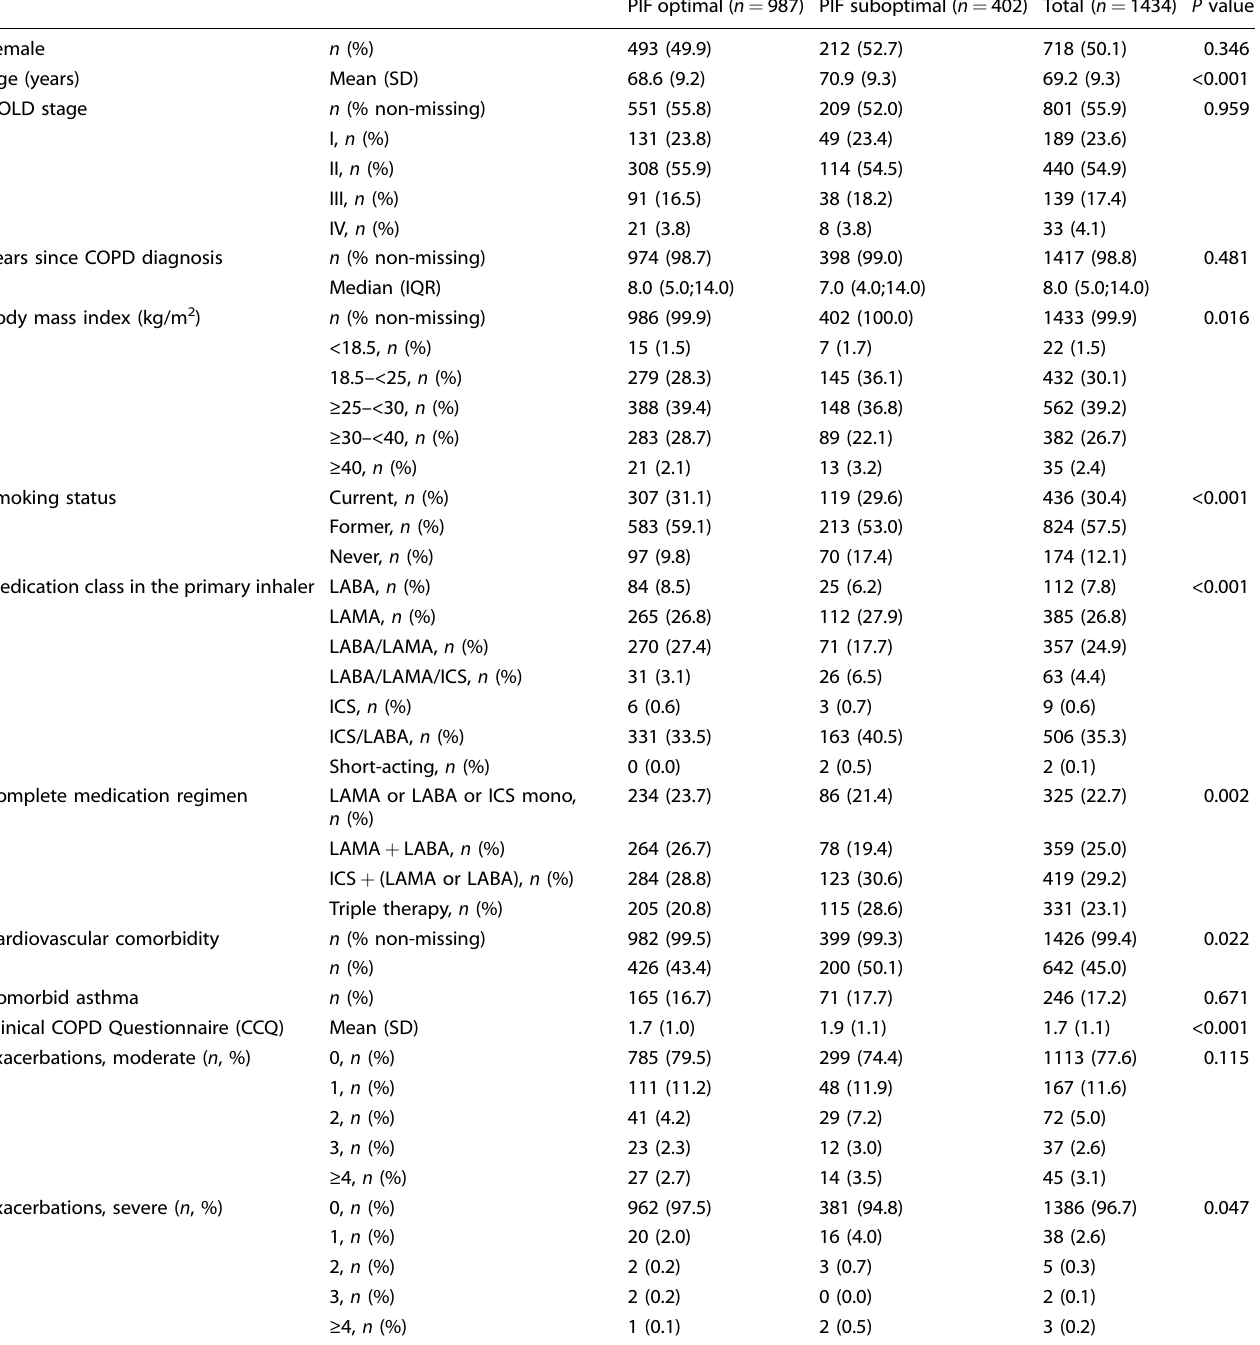
Table 1. Overview of participant